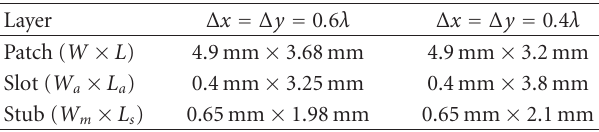
Table 3: Antenna dimensions (reflectarray unitary cell equal to: Δ x = Δ y = 0 . 6 λ and Δ x = Δ y = 0 . 4 λ